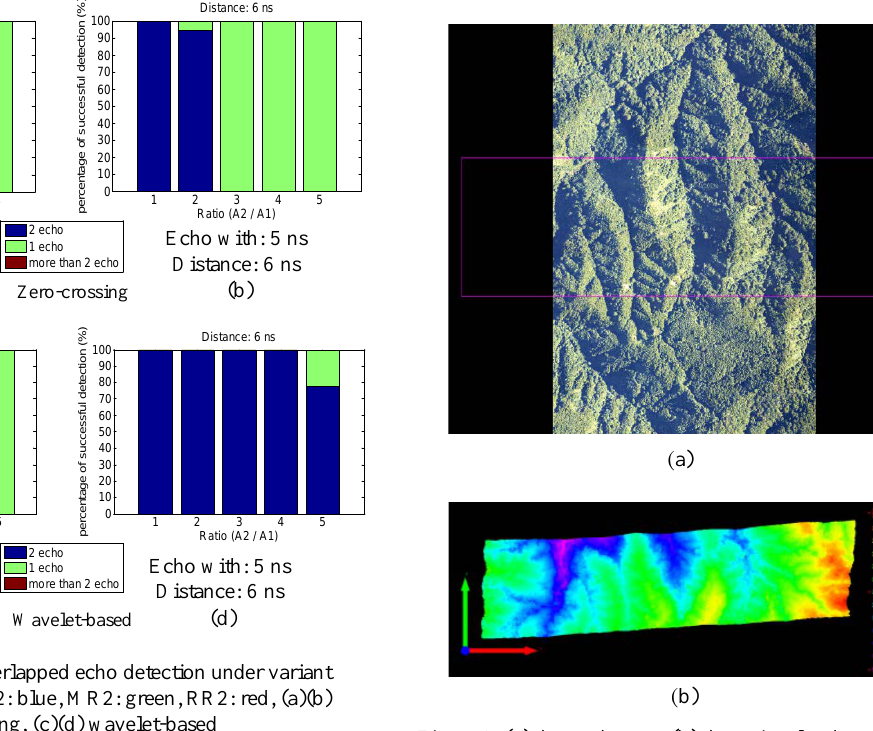
Figure 9. (a) the study area, (b) the point clouds colored by elevation in the rectangle area of (a).